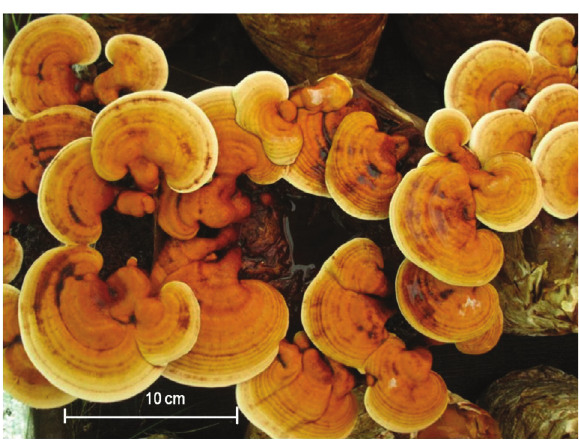
Fig. 1 – Ganoderma lucidum in nature (Photo A. Gregori)